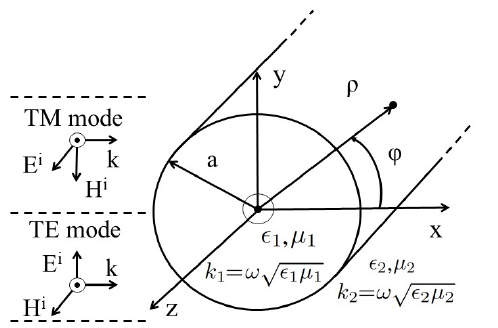
Figure 1. A uniform TM / TE plane wave with + x as direction of propagation in free space is incident on cylindrical nanowire of radius a